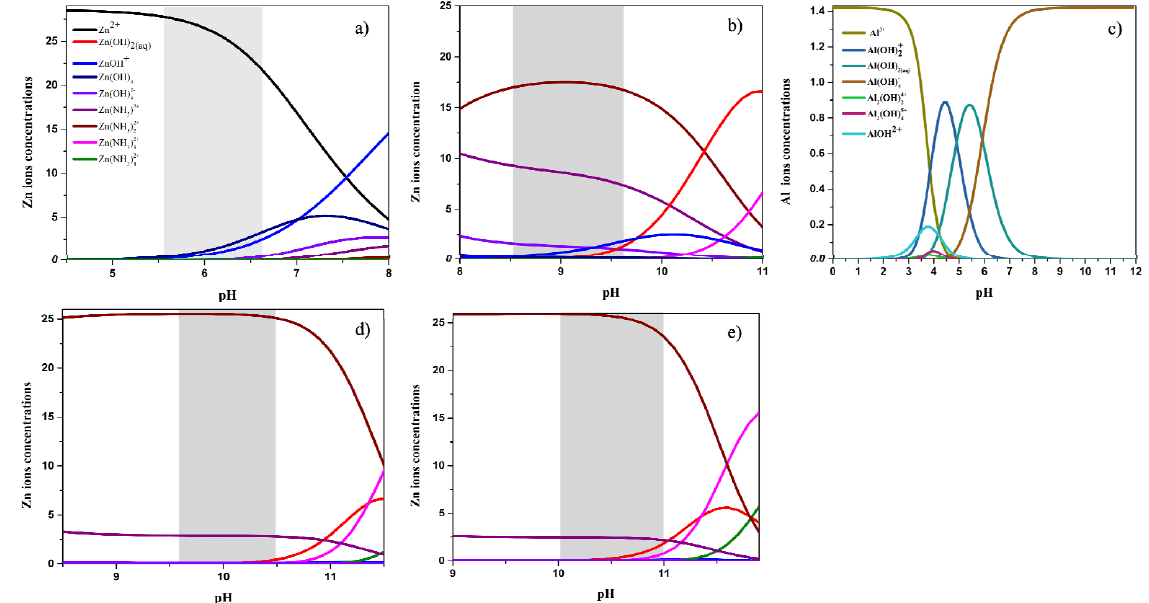
Figure 6. Theoretical calculations of ions concentrations as a function of pH using the Visual MINTEQ software: ( a , b , d , e ) Zn(II) speciation diagram at various pH and ammonia concentration, ( c ) Al(III) speciation diagram. Note that the HMTA is replaced by an equivalent amount of NH 3